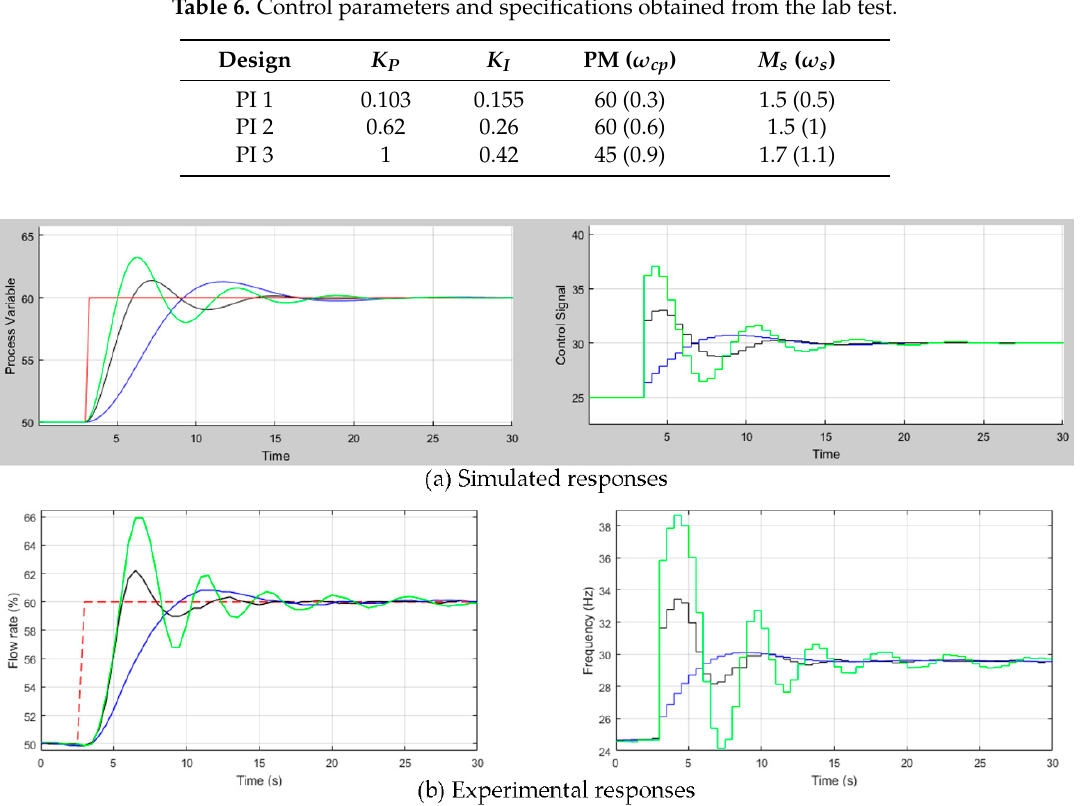
Figure 11. Simulated ( a ) and experimental ( b ) closed loop responses (PI 1 in blue color, PI 2 in black, and PI 3 in green).